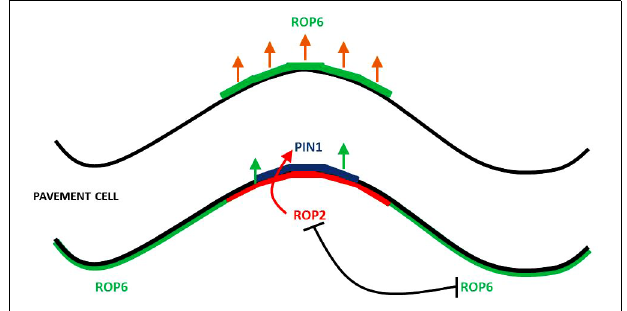
FIGURE 1 | Rho-like GTPase activation regions and PIN1 localization in leaf PCs. ROP2 promotes the localization of PIN1 to the lobe tip